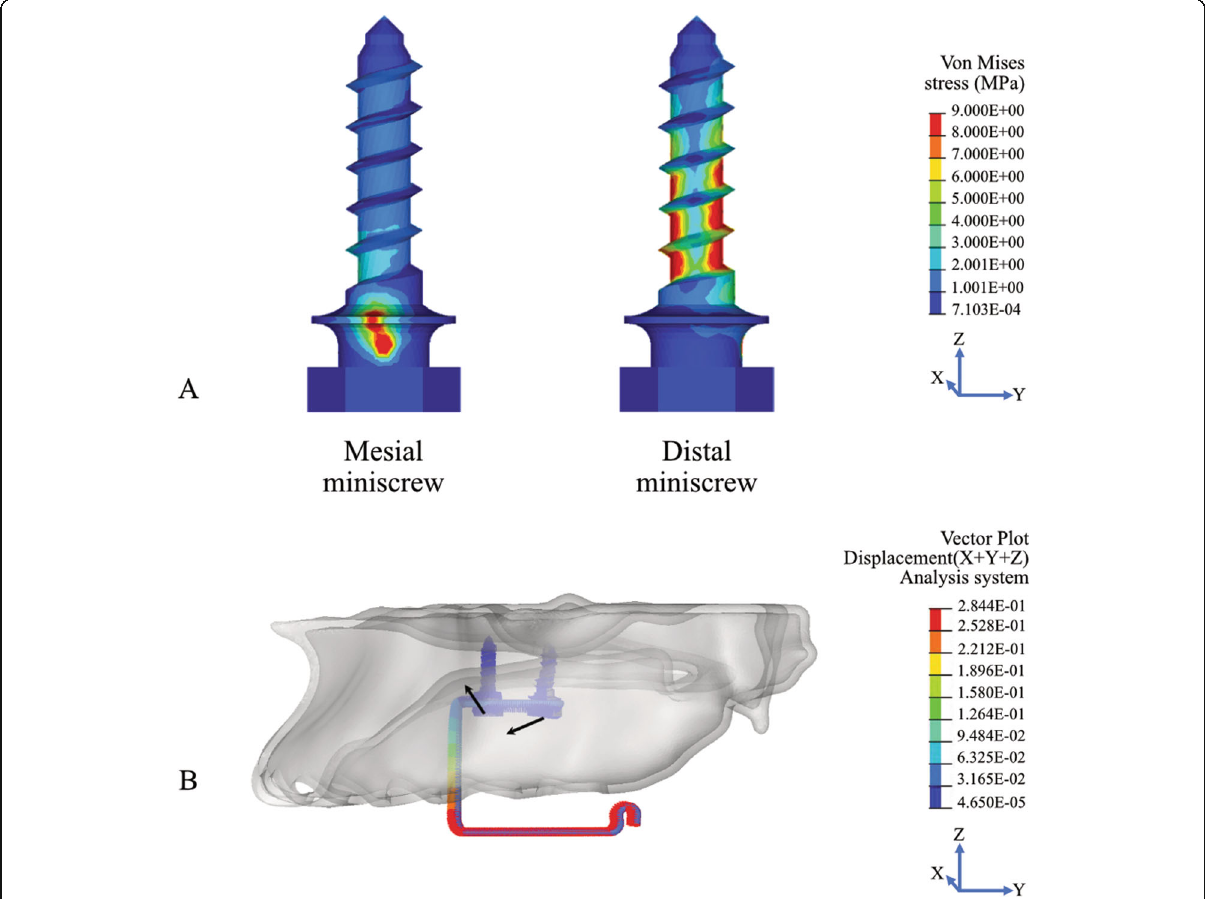
Fig. 4 a The von Misses stress in mesial and distal miniscrew. b The direction of miniscrews displacement. The mesial miniscrew had mesial tipping with intrusive vectors, and the distal miniscrew had mesial tipping with extrusive